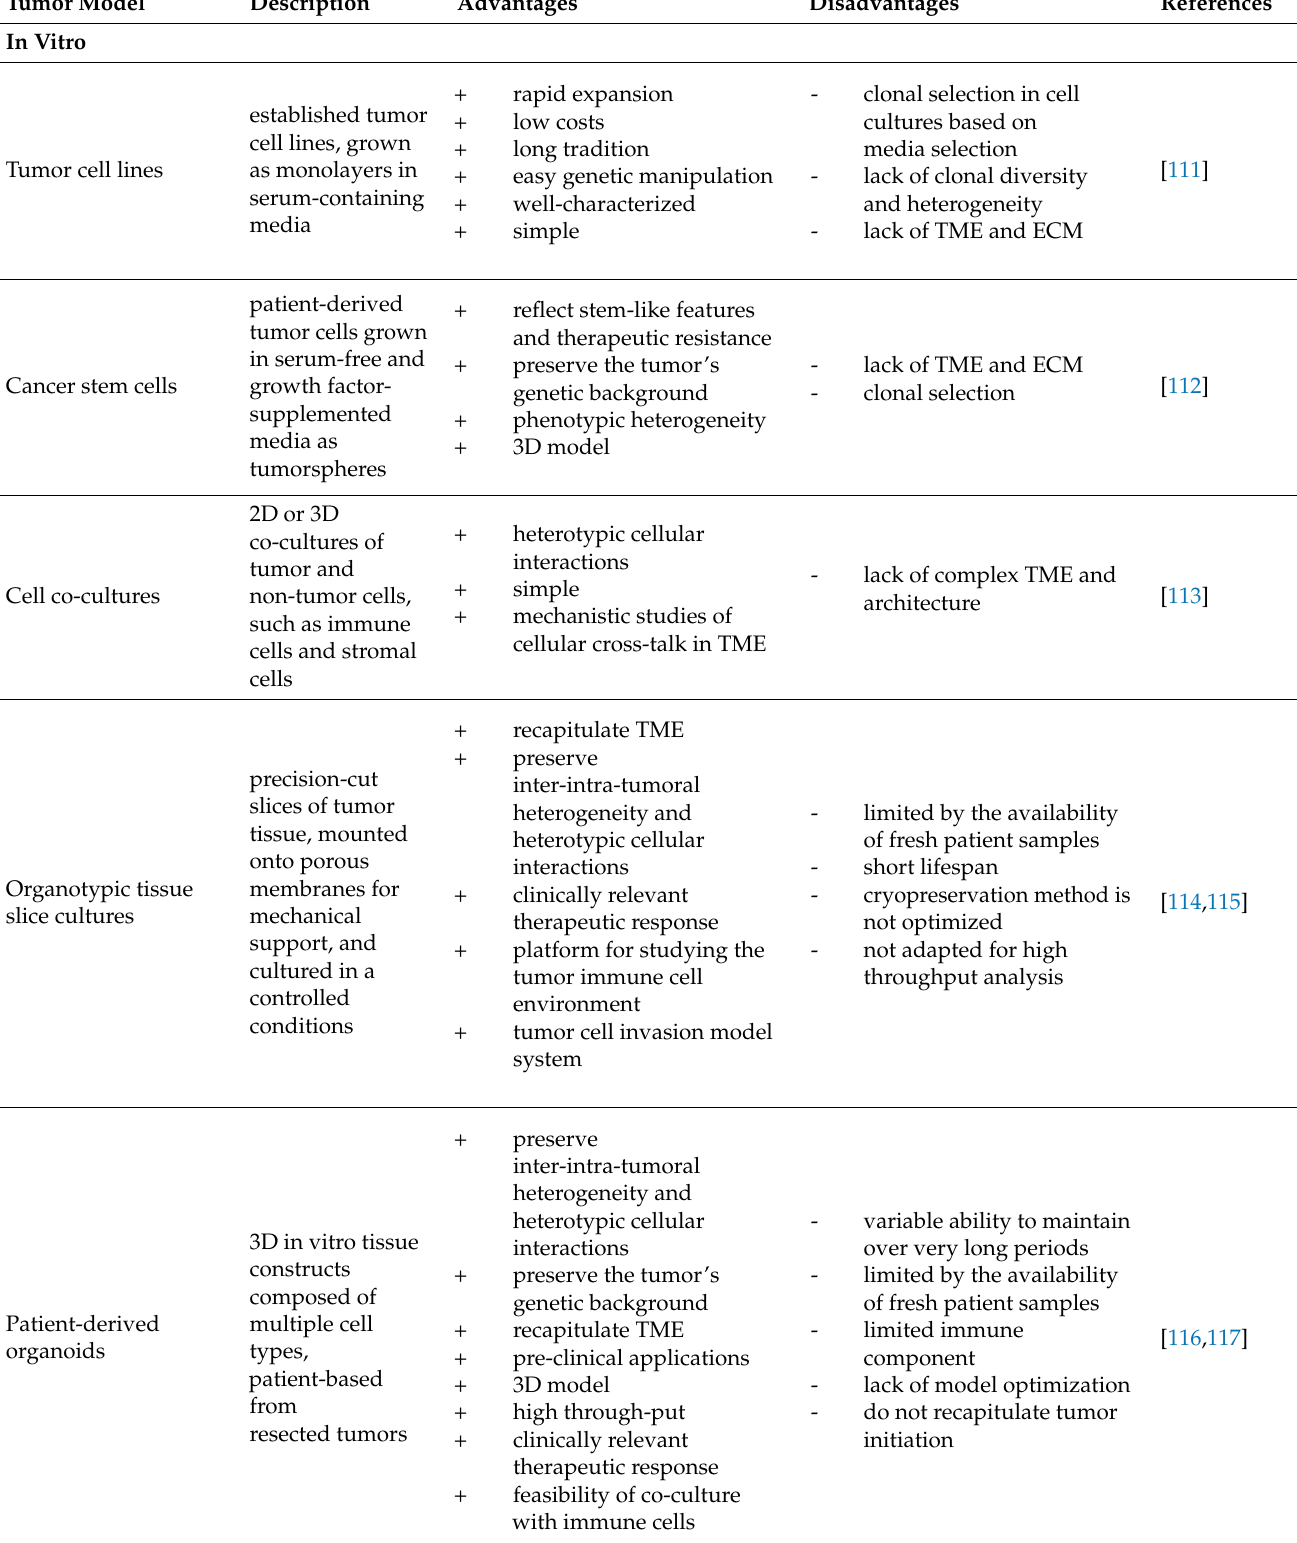
Table 1. A comparison of different glioblastoma tumor models for studying immunotherapy. Tumor